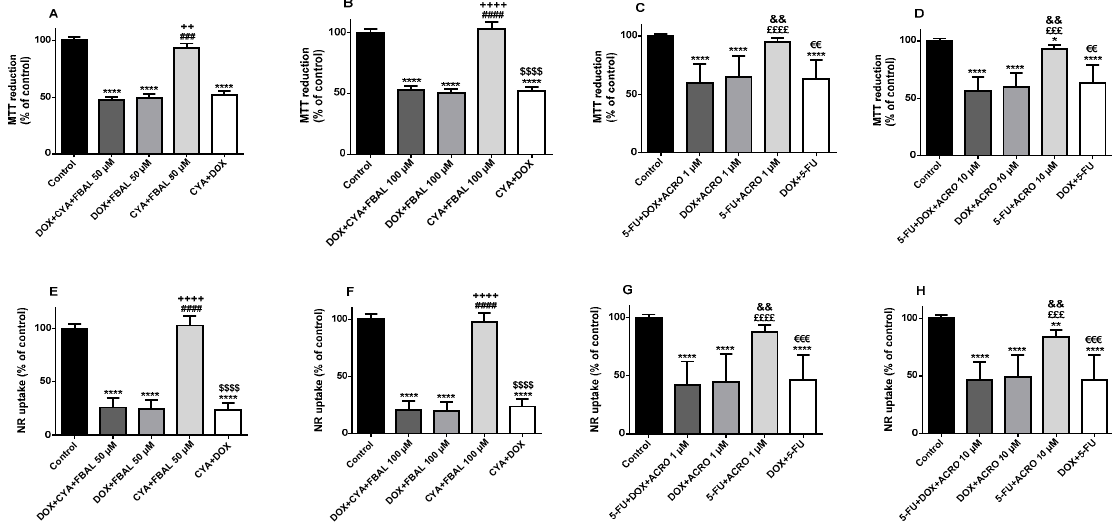
Figure 5. Cytotoxicity evaluated by ( A – D ) the MTT reduction assay (three to five independent experiments (total of 12–24 wells)) and ( E – H ) the NR uptake assay (six to eight independent experiments (total of 24–32 wells)) in differentiated H9c2 cells incubated for 48 h with DOX + CYA + FBAL (FBAL at concentrations of 50 or 100 μ M; DOX 1 μ M; and CYA 50 μ M) or with 5-FU + DOX + ACRO (ACRO 1 or 10 μ M; DOX 1 μ M and 5-FU 50 μ M). Results are presented as mean ± SD. Statistical